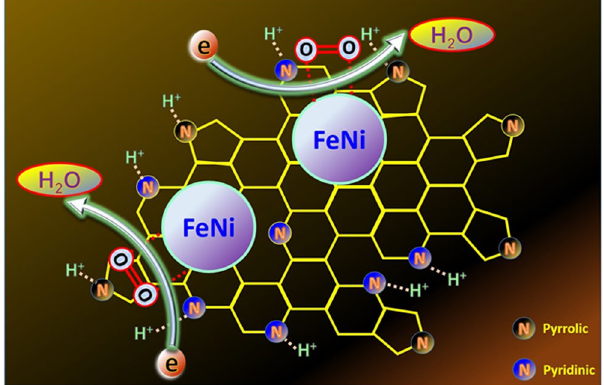
Figure 3. Schematic diagram for the oxygen reduction mechanism using the synthesized FeNi- N-Gr.